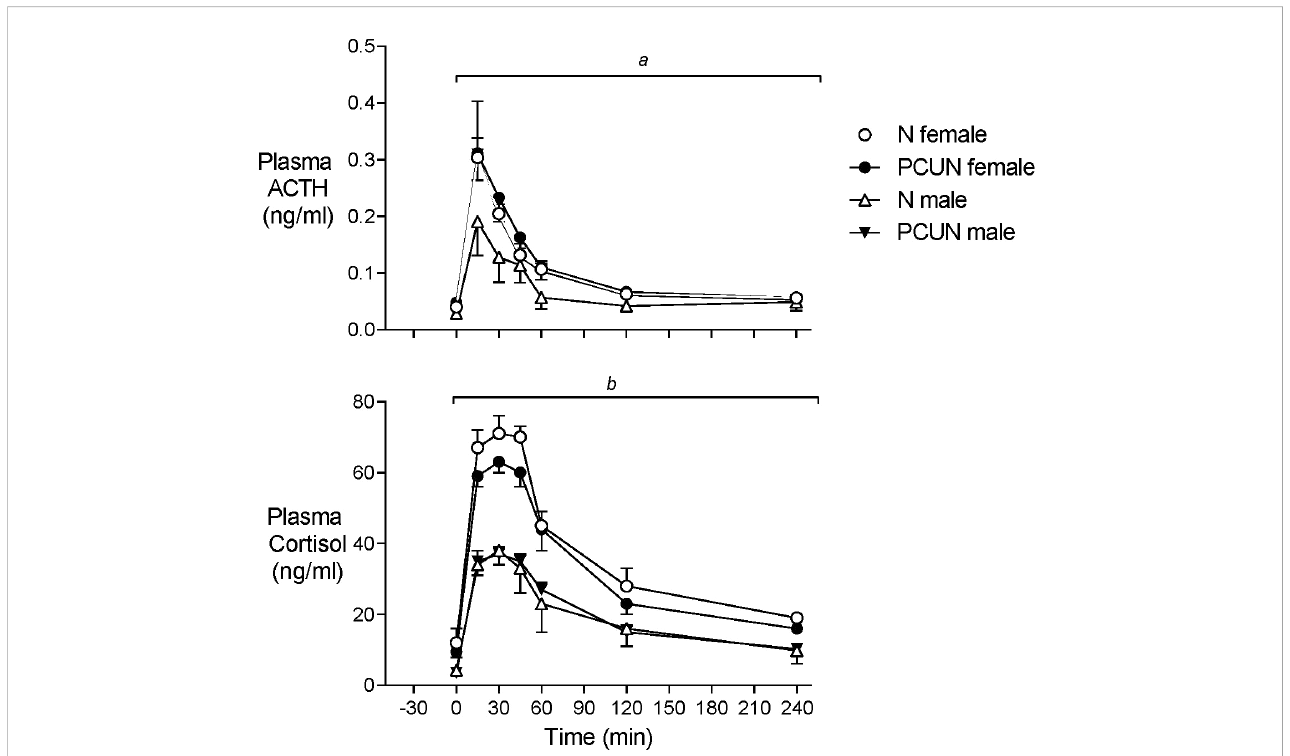
FIGURE 4 Adult plasma ACTH and cortisol responses to equimolar challenge of intravenous AVP+CRH (0.1 and 0.5 m g/kg respectively) given at time ‘ 0 ’ . a treatment x time interaction in males. b sex effect ( p < 0.0001). Values are mean ±